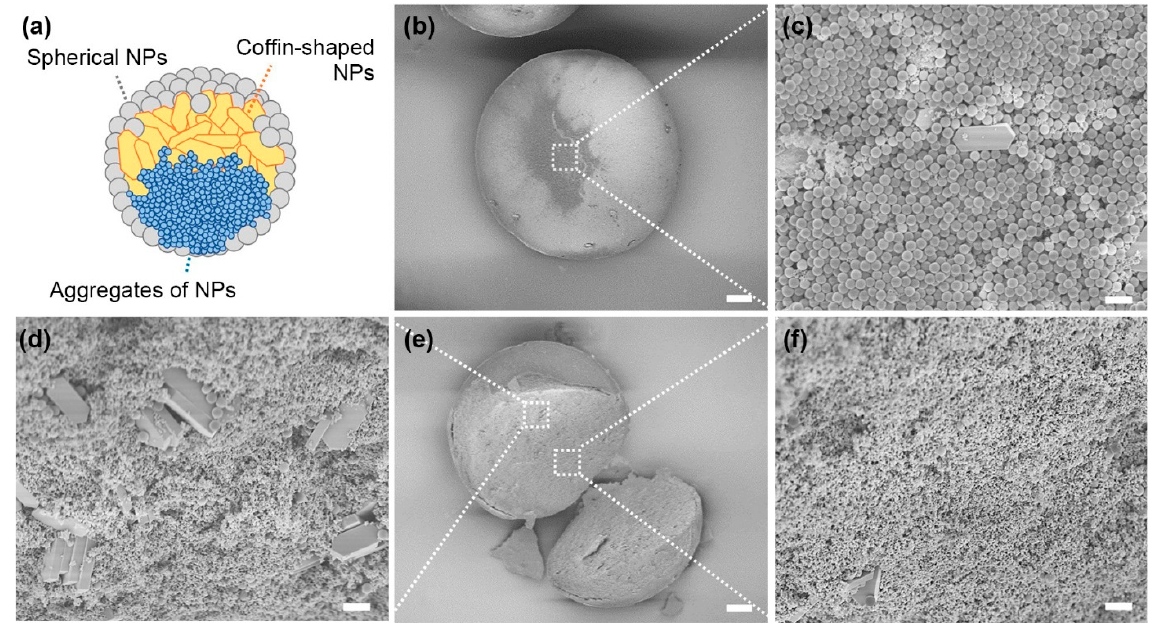
Figure 9. Janus core/shell structured supraparticle. ( a ) A schematic of the tri-composite supraparticle with aggregates of NPs/coffin-shaped NPs/spherical NPs. ( b , c ) SEM images of the surface of Janus core/shell supraparticle. ( d ) High magnification the SEM image of the inner-structure of the Janus core/shell structured supraparticle; the shell. ( e ) Cross-sectional SEM image of the Janus core/shell structured supraparticle, characterized after breaking the supraparticle. ( f ) High magnification SEM image of the inner-structure of the Janus core/shell structured supraparticle; the core. The scales are 100 μ m for ( b , e ), 1 μ m for ( c , d , f ).